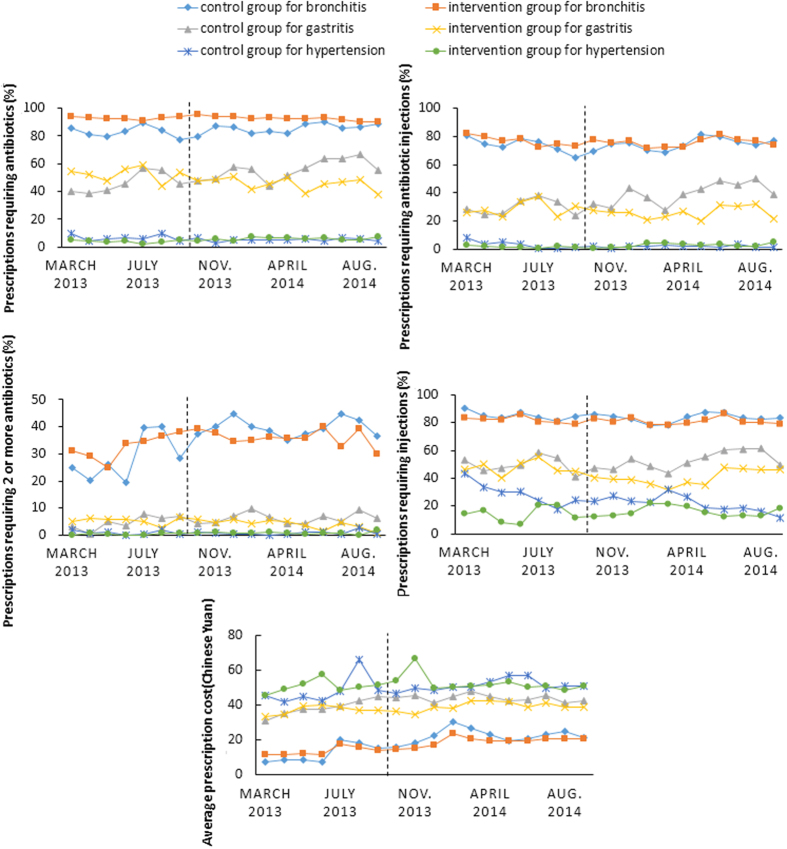
Monthly results of prescribing indicators over time.To make a clearer view, the average cost of bronchitis were 10 minus on every single dot for both intervention and control groups.